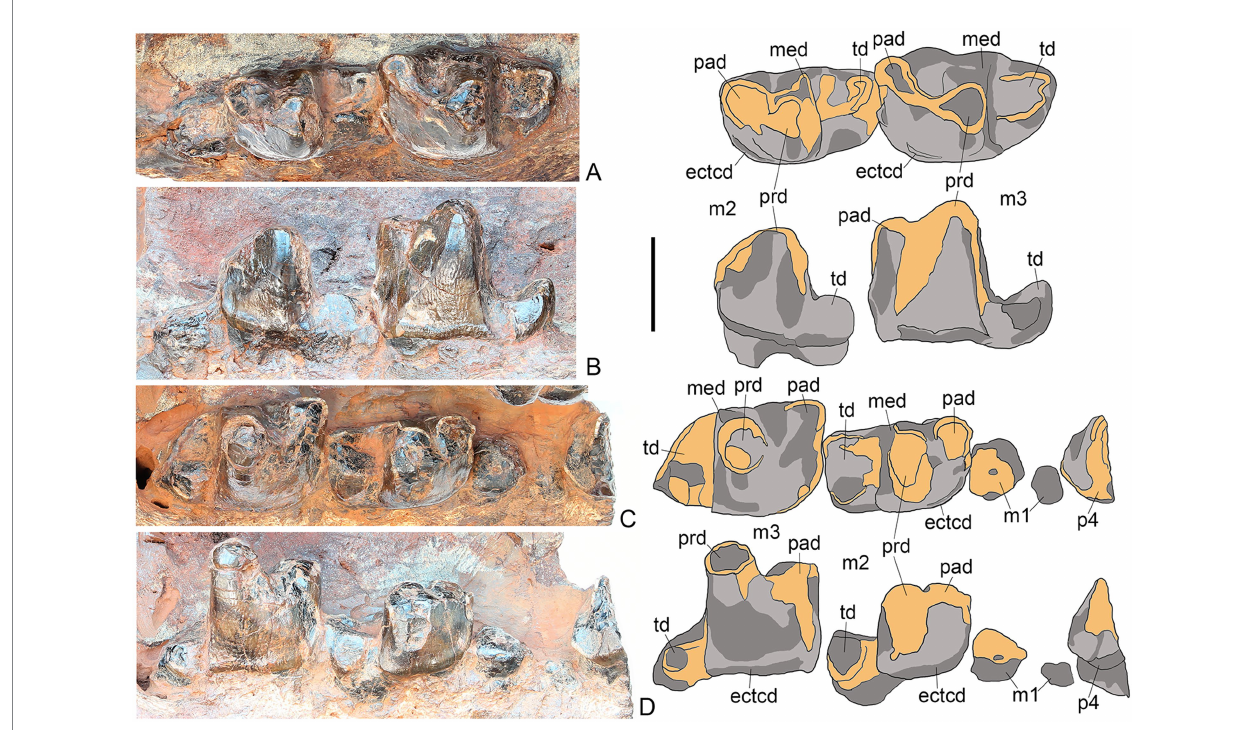
FIGURE 8 M. peregrinus , gen. et sp. nov., SYSU-M-5, holotype, lower dentition (photographs and explanatory drawings). Youganwo Formation, upper Eocene, Maoming locality, Guangdong Province, China. A, B, left m2-3, in occlusal (A) and labial (B) views. (C,D) , right p4, m1-3, in occlusal (C) and labial (D) views. ectcd, ectocingulid; med, metaconid, pad, paraconid; prd, protoconid; td, talonid. Scale bar equals 1